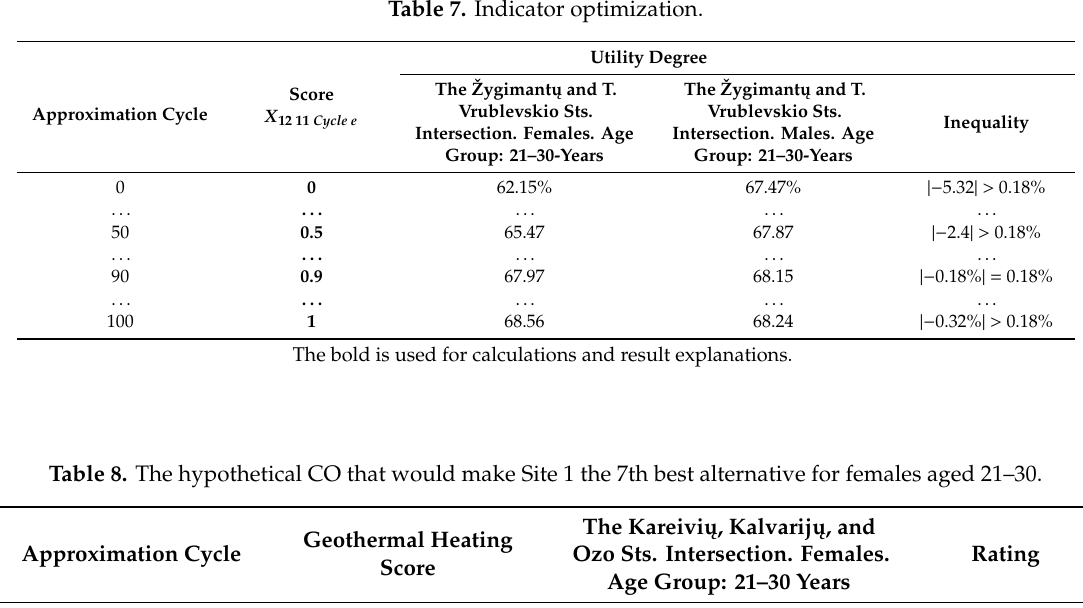
Approximation Cycle